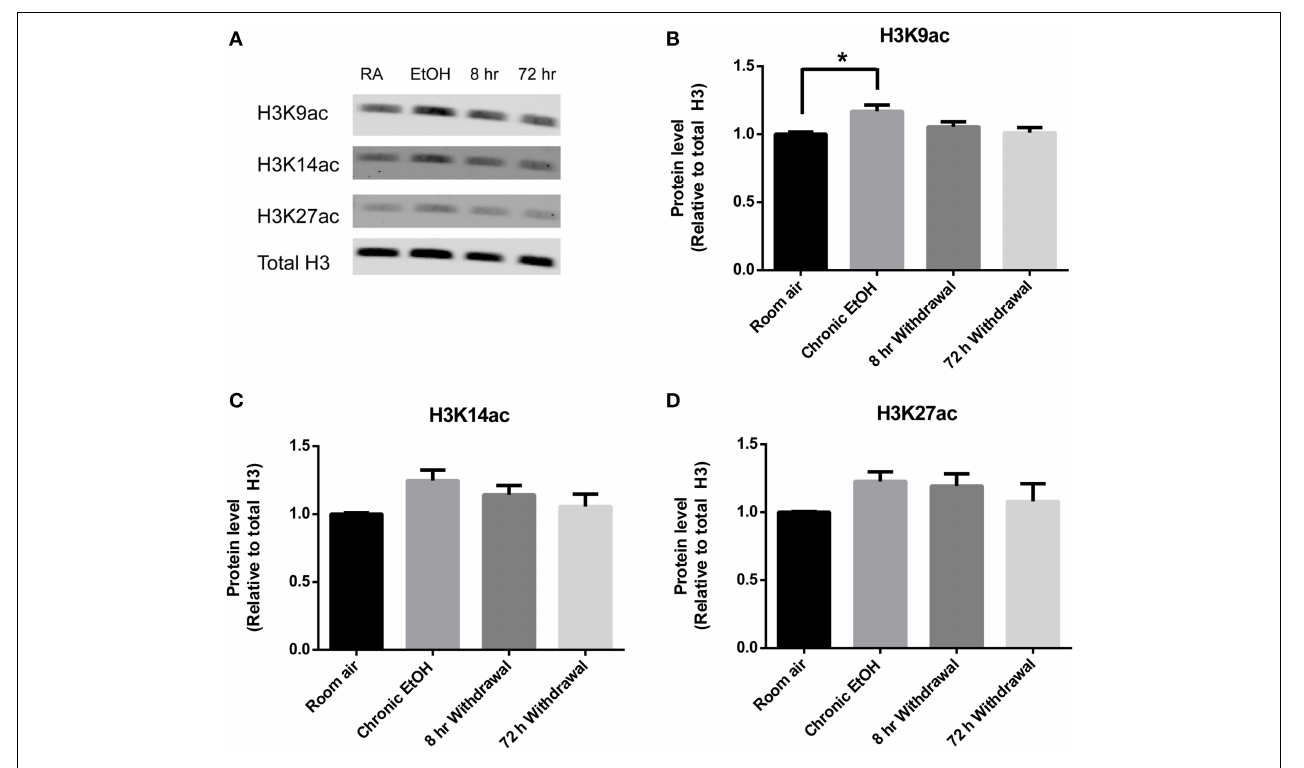
FIGURE 3 | Chronic intermittent EtOH transiently potentiates histone acetylation in the PFC. (A) Western blot showing one sample from 5/group analyzed in duplicate. Western blot revealed (B) a significant effect of EtOH exposure on H3K9ac ( p < 0 . 05 ) and